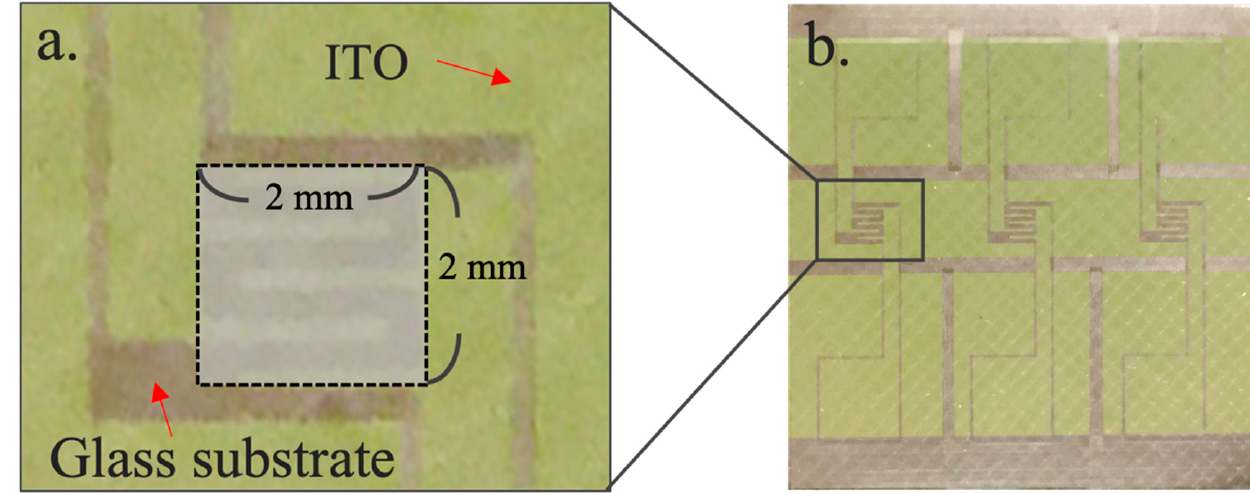
Table 1. Detailed information of non-sintered NiO nanoparticle thin films as fabricated by aerosol jet.